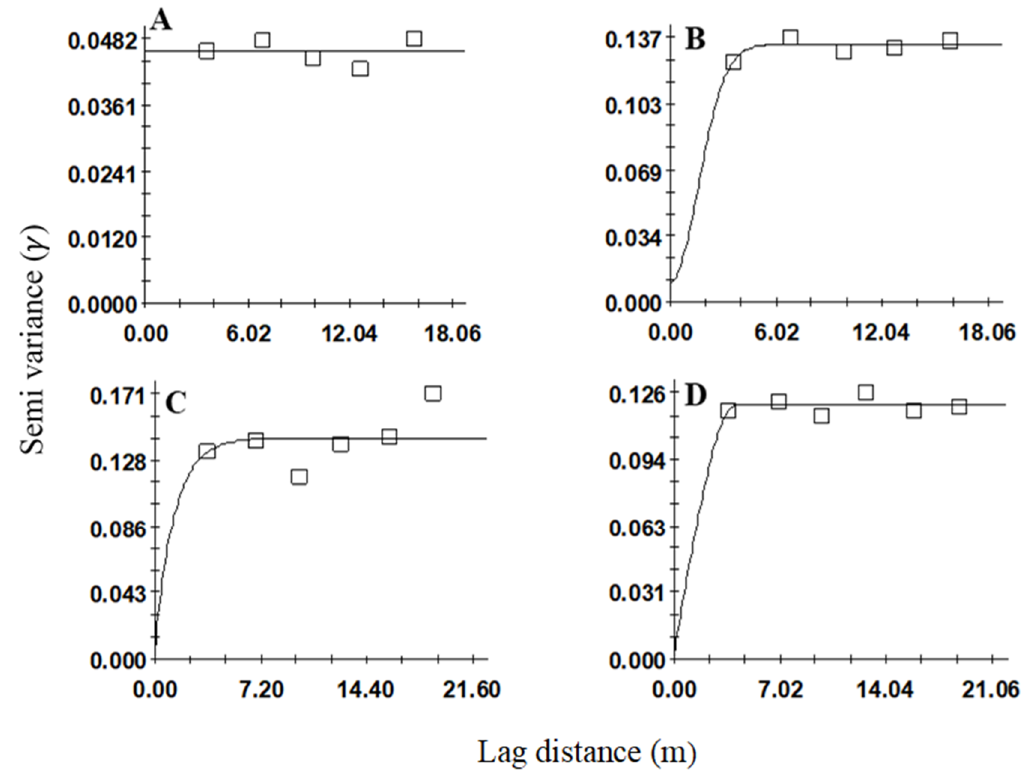
Figure 3. Variogram models showing the spatial distributions of Sphenophorus spp. larvae in sites ( A ) 1, ( B ) 2, ( C ) 3, and ( D ) 4. Sites 1 and 2 were sampled in fall and winter 2019, and sites 3 and 4 spring 2020. Spatial aggregations were observed at all three sites (2, 3, and 4) for the adult S. vena- tus vestitus populations. Variogram analyses were conducted separately on adult data for each week and cumulatively (all three weeks combined) for all three sites. For the cumu- lative samples, the best-fitting variogram used the exponential model at all three sites ( r 2 = 0.52, 0.08, 0.2 at sites 2, 3, and 4, respectively) (Table 2, Figure 4A–C). Spatial aggregation was detected in all three sampling weeks for sites 2 ( r 2 = 0.003, 0.5, and 0.13) and 3 ( r 2 = 0.24, 0.82, and 0.003), whereas at site 4, spatial aggregation was not evident in the second sample (Table 2). The best-fitting model for site 2 was the spherical model for the first week, whereas the exponential model fitted well for the two following sampling weeks (Table 2). At site 3, the best-fitting models were exponential models for all three sampling weeks. At site 4, the spherical model was the best-fitting model for the first week, whereas the linear and exponential models fitted well for the following two weeks. The nugget-to- sill ratios were <0.25, which indicated a high degree of aggregation for all three sites for the cumulative data and for all weekly sampling data for sites 2 and 3 (Table 2). For site 3, the nugget-to-sill ratio was <0.25 for the second week of sampling.